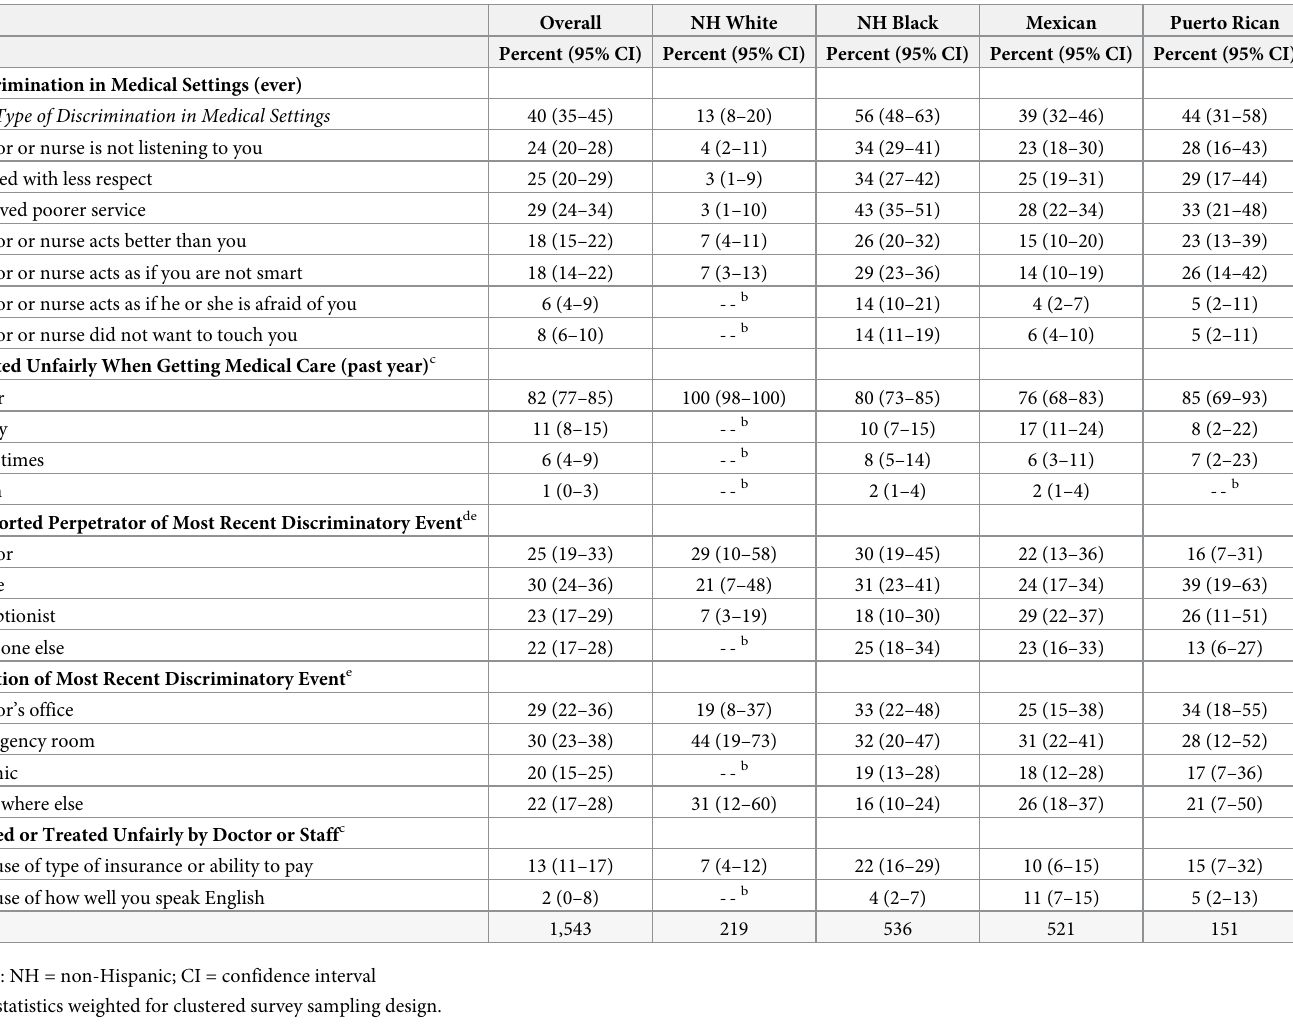
Table 2. Perceived discrimination in medical settings and related factors by race/ethnicity, Sinai Community Health Survey 2 . 0 (2015–2016, ten Community Areas in Chicago, IL) a